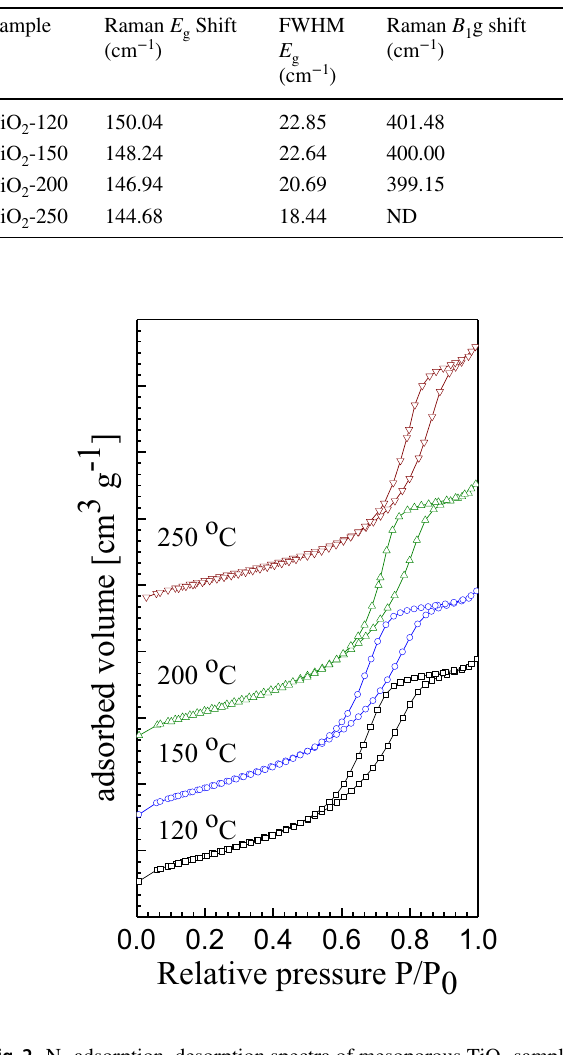
2 samples from N 2 adsorption/des-